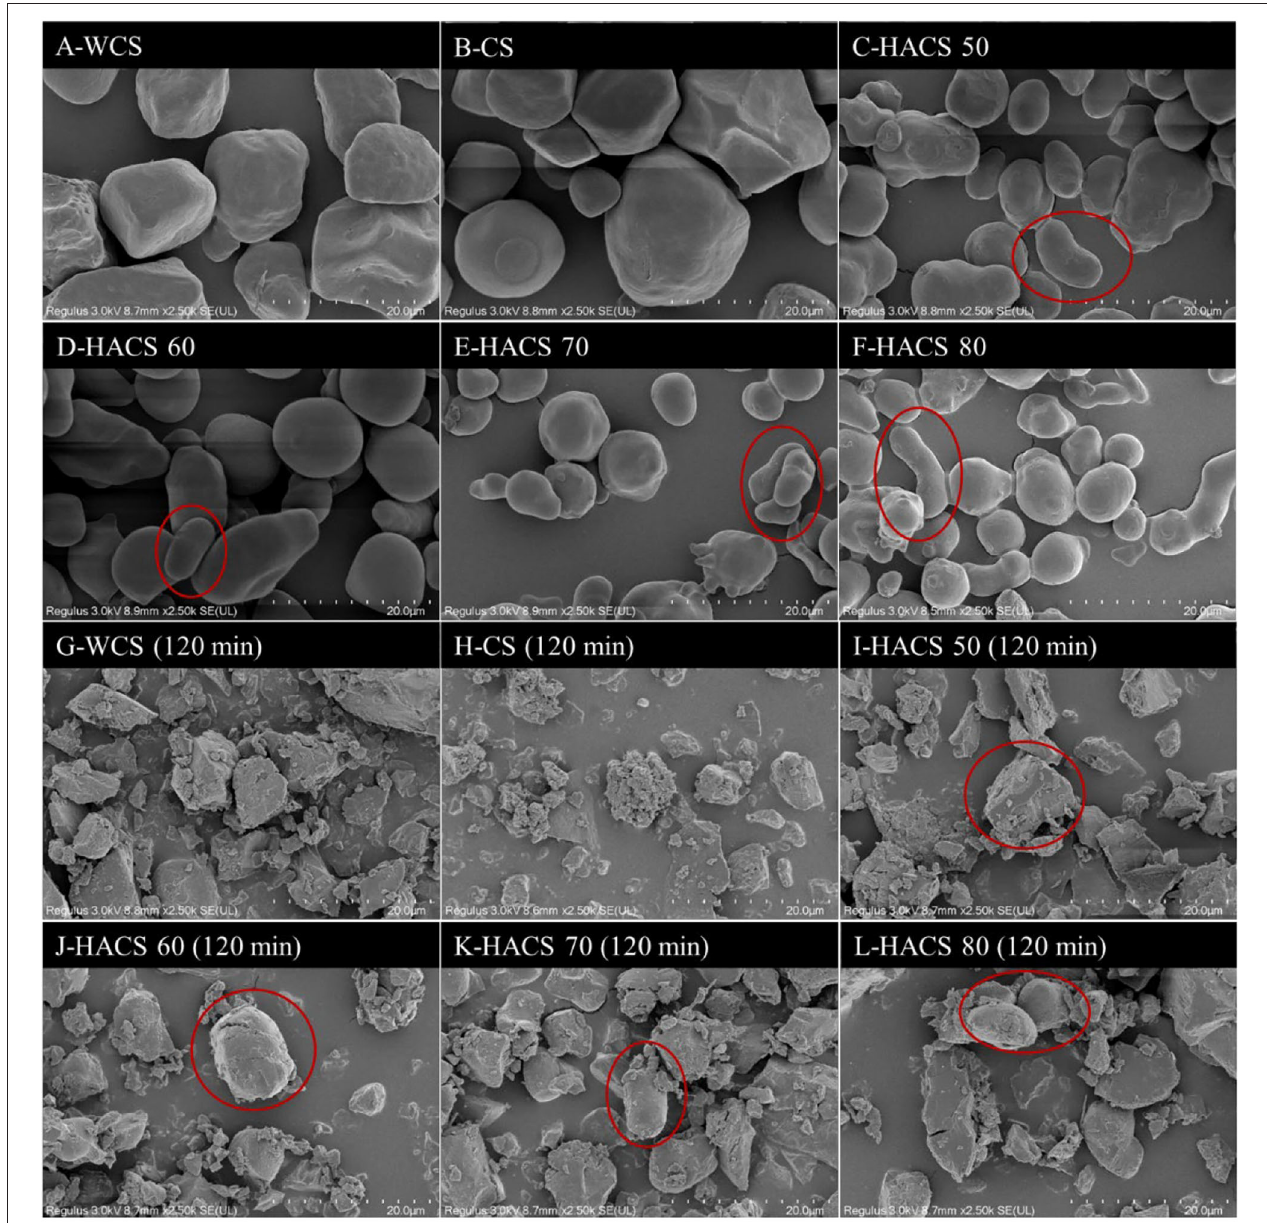
FIGURE 4 | The morphology of corn starch with different amylose content (A–F) and the morphology of corn starch (G–L) after enzymolysis for